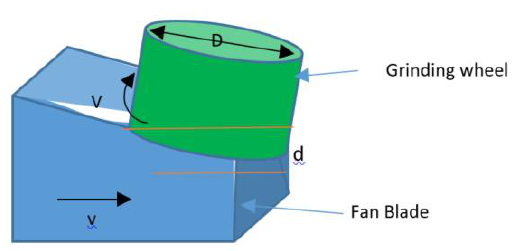
Figure 5. Grinding depiction picture.